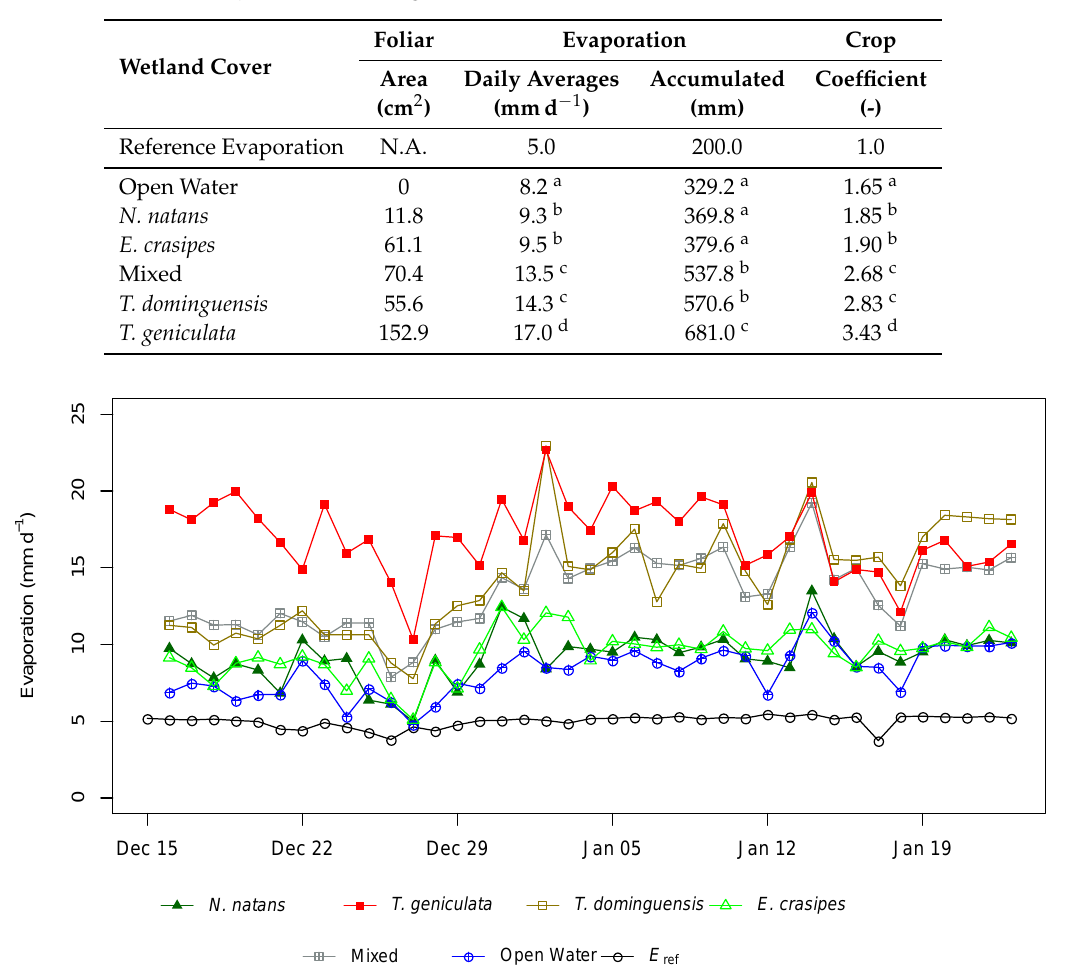
Table 1. Average values of crop coefficient, daily and accumulated evaporation rates for the selected wetland covers at Palo Verde National Park, Costa Rica. Each average is based in 40 days of measurements and five replicates. Average values on the same column with similar lower case letters ( a,b,c,d ) do not show statistical differences ( p = 0.05) according to the Fisher LSD test.